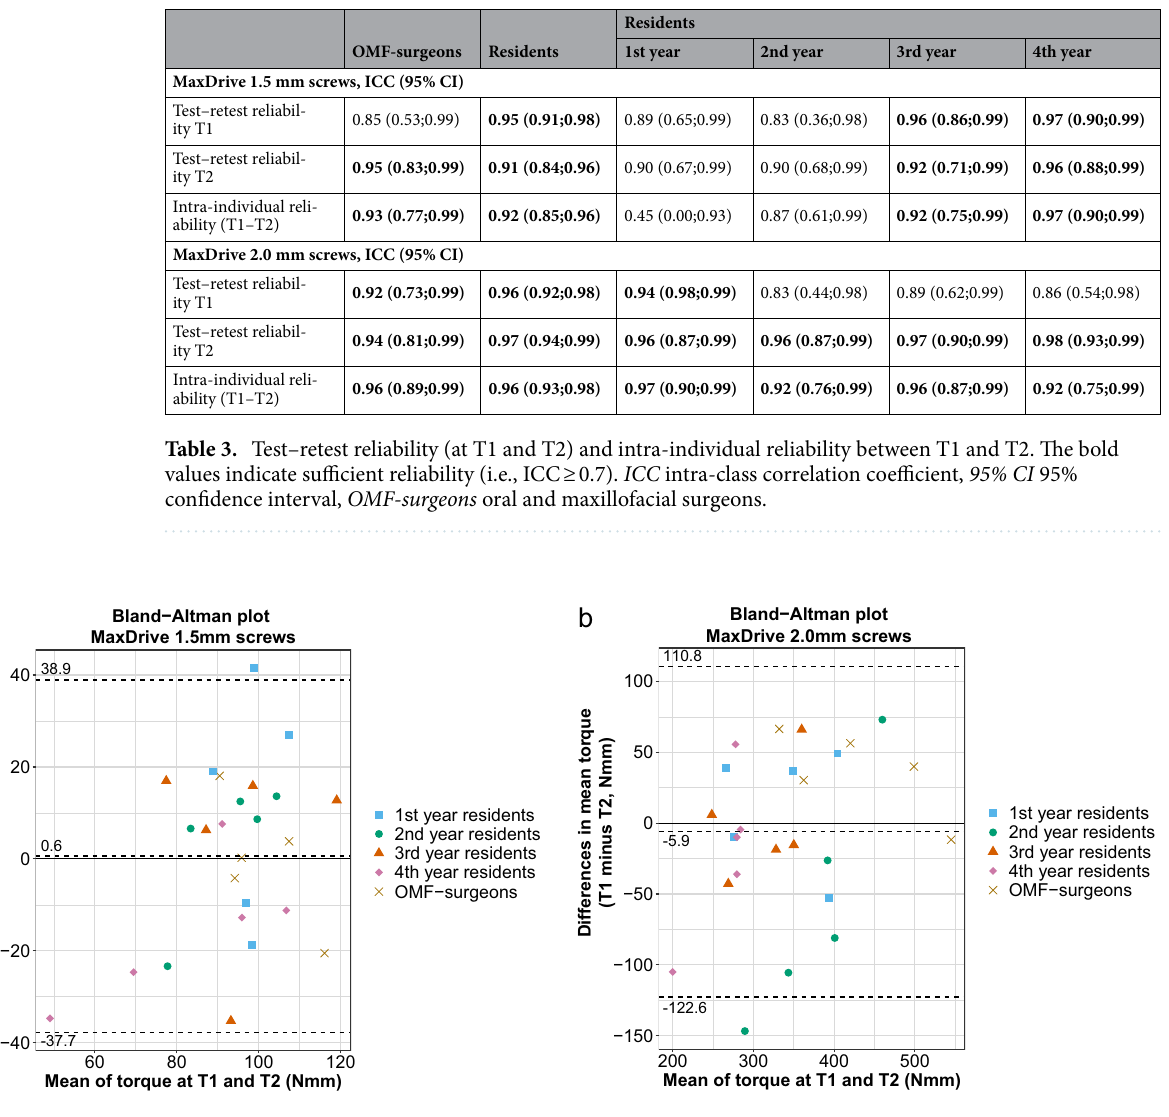
Figure 4. Bland–Altman plots of the ( a ) 1.5 mm and ( b ) 2.0 mm osteosynthesis screws. The dotted lines represent the lower and upper limits of agreement and the systematic difference accompanied by the corresponding values. The 95% CI of the systematic difference of the 1.5 mm screws is − 7.4 to 8.7 Nmm, and that of the 2.0 mm screws is − 30.5 to 18.7 Nmm. OMF oral and maxillofacial, CI confidence